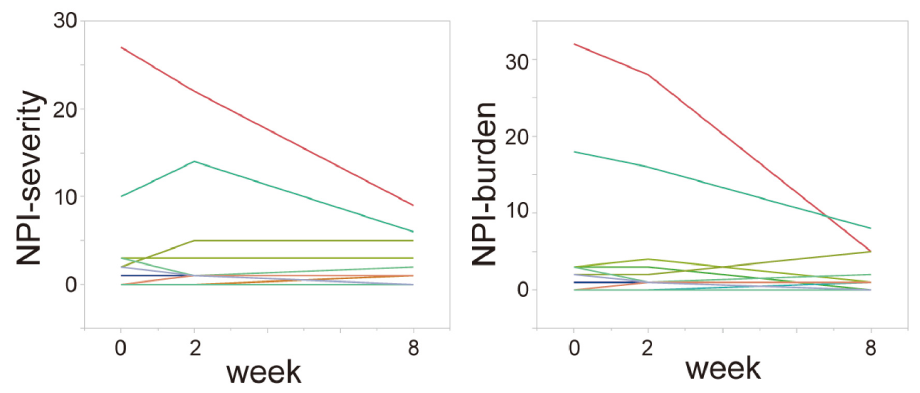
Fig 3. NPI-Q scores of 20 PD patients at T0, T1, and T2. The severity and burden scores remained low for most participants, but both scores were remarkably reduced for the two participants with relatively high baseline scores.